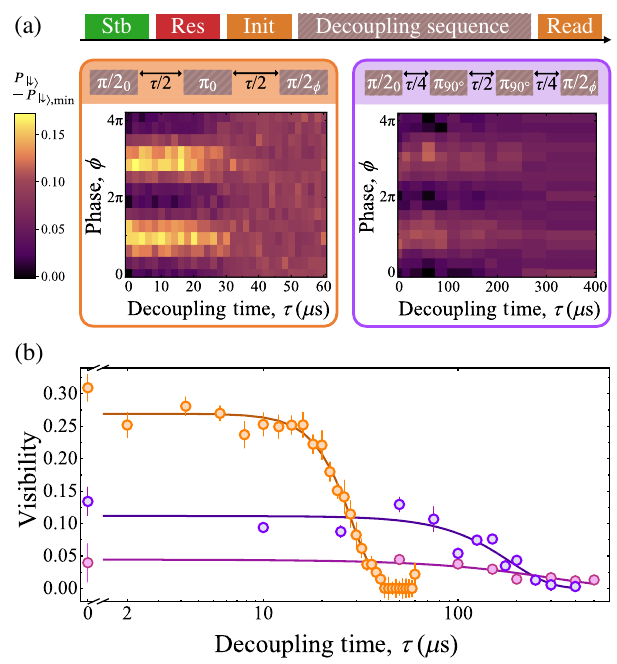
FIG. 4. Dynamical decoupling. (a) Decoupling pulse sequence (top) with two implementations: (left orange panel) Hahn echo, (right purple panel) CPMG-2. The phase ϕ of the second π = 2 pulse is variable. In both panels, color indicates the j ↓ i popu- lation shown as a function of the total decoupling time τ and phase ϕ . (b) Visibility a=b obtained from fitting the function a cos ð ϕ Þ þ b to the data shown in (a) at each delay time τ plotted as a function of τ . Hahn echo data (orange circles) are fitted to the function v 0 exp ½ − ð τ =T 2 Þ n (cid:3) þ v ∞ , where v 0 ¼ 0 . 26 ð 1 Þ , v ¼ 0 . 013 ð 5 Þ , n ¼ 3 . 7 ð 4 Þ , and T ¼ 28 . 3 ð 6 Þ μ s (solid orange ∞ 2 curve). CPMG-2 data (purple circles) are fitted to the same function with v 0 ¼ 0 . 11 ð 1 Þ , n ¼ 2 . 1 ð 9 Þ , T 2 ¼ 0 . 19 ð 2 Þ ms, and v ∞ is fixed to 0 (solid purple curve). CPMG-4 data (see Supplemental Material [61] Sec. X) are plotted (pink circles) and fit to the same function with v 0 ¼ 0 . 044 ð 7 Þ , n ¼ 1 . 2 ð 6 Þ , T ¼ 0 . 30 ð 8 Þ ms, and v 2 ∞ is fixed to 0 (solid pink